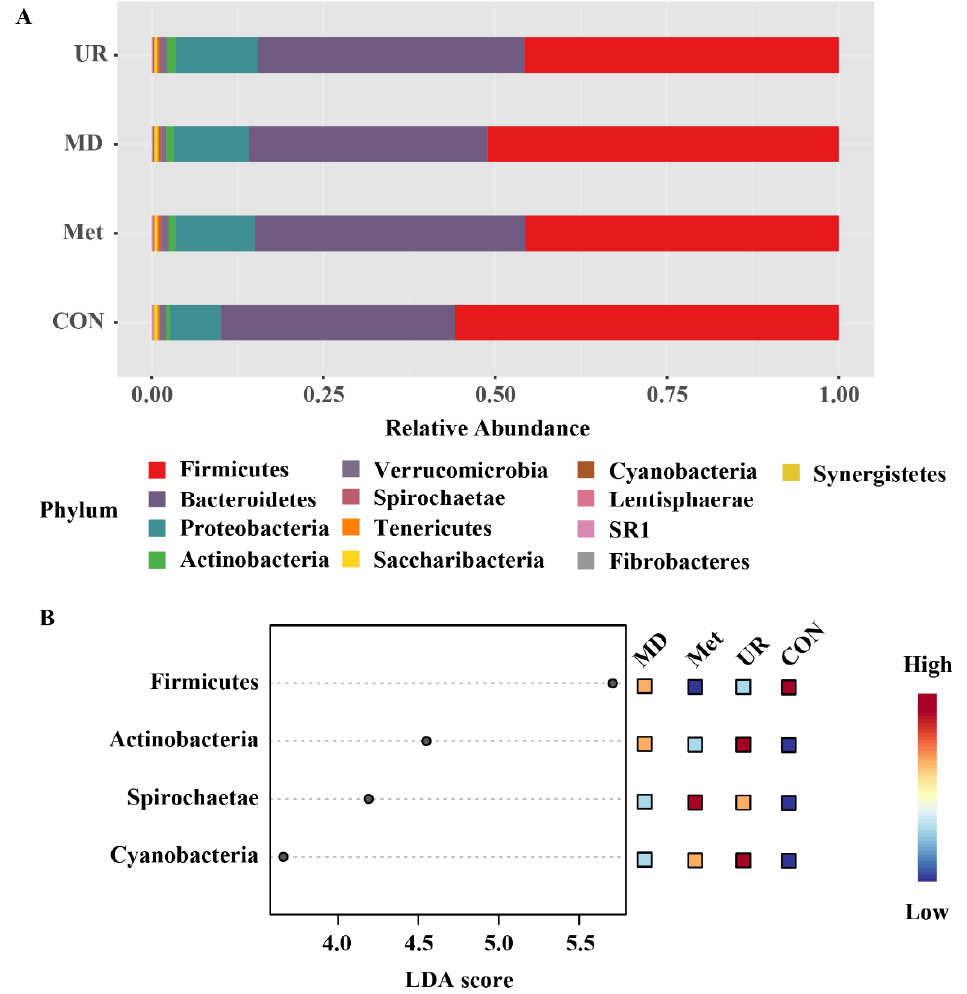
Figure 5. Phylum composition ( A ) of the microbiota and linear discriminant analysis effect size (LEfSe) ( B ) identifying differential phyla of microbiota in response to urea, methionine, or methionine dipeptide supplementation. CON = no additive, UR = urea addition, Met = methionine addition, and MD = methionine dipeptide addition. A cut-off value ≥ 2 was used for the linear discriminant analysis (LDA) score. n = 5 per treatment per time.